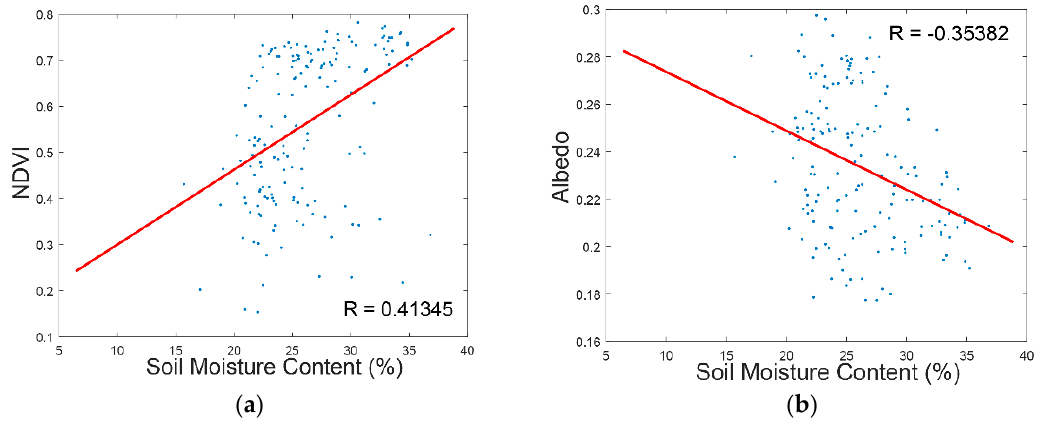
Figure 5. Correlation analysis between auxiliary variables (NDVI and albedo) and soil moisture: ( a ) the NDVI data was derived from the five available HJ satellites images and compared with the soil moisture data observed by WSN of the corresponding dates; ( b ) the albedo data was derived from the five available HJ satellites images and compared with the soil moisture data observed by WSN of the corresponding dates.